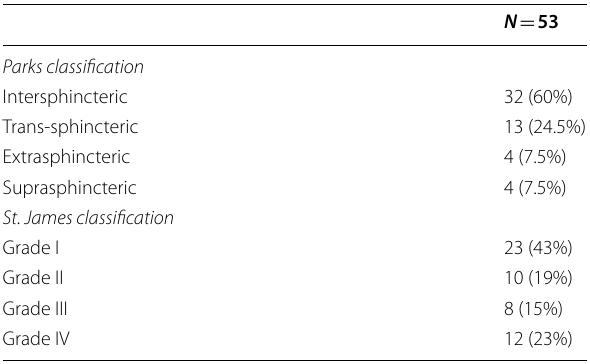
Table 4 Parks and St. James classification of perianal fistula in